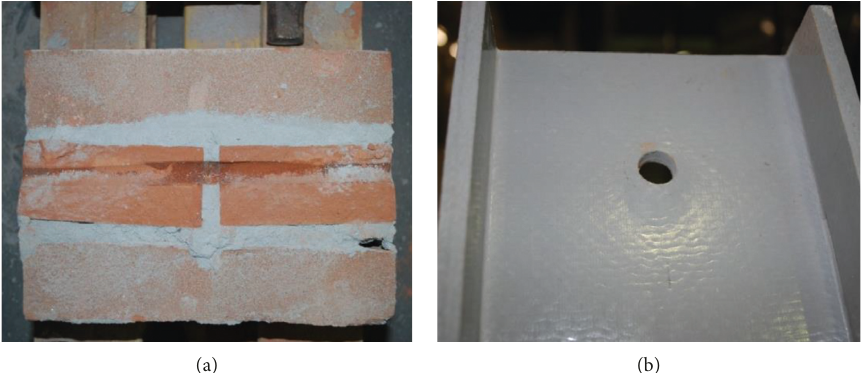
Figure 6: Collapse mechanism of samples 3a-b (a) and condition of pultruded profile after the test